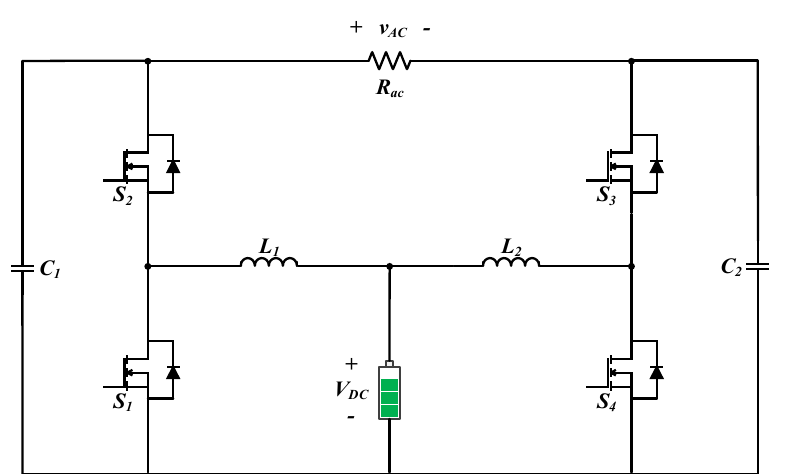
Figure 5. The schematic of the SSDBI.